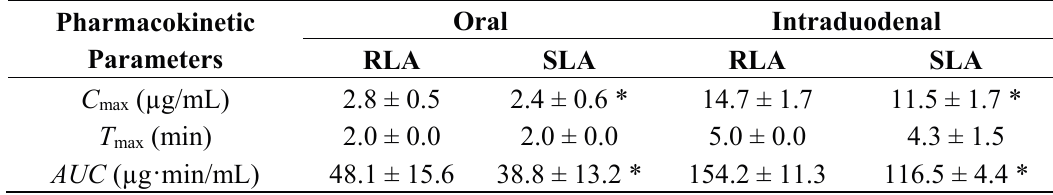
Table 3. Pharmacokinetic parameters of α -lipoic acid after oral and intraduodenal administration of the racemic mixture to pylorus ligated rats.